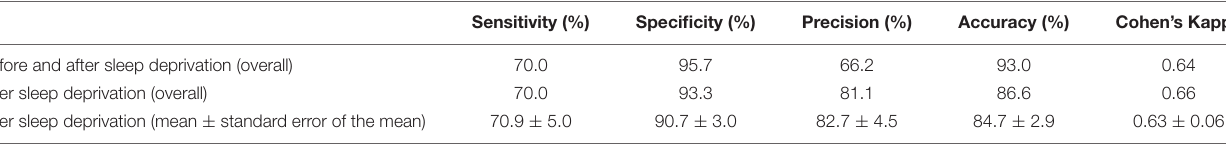
TABLE 1 | Performance of automatic microsleep episode (MSE) detection compared to visual scoring in the maintenance of wakefulness test (MWT) trials of 10 participants before and after sleep deprivation. Sensitivity (%) Specificity (%) Precision (%) Accuracy (%) Cohen’s